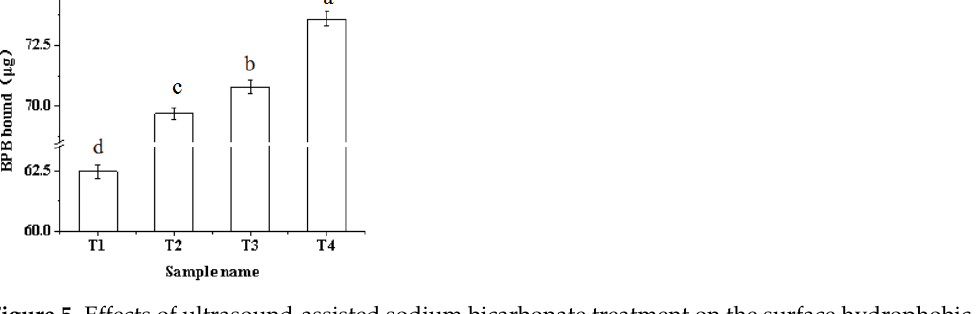
Figure 5. Effects of ultrasound-assisted sodium bicarbonate treatment on the surface hydrophobic of raw pork myofibrillar protein. T1, sodium bicarbonate 0 g, ultrasound time 0 min; T2, sodium bicarbonate 0.2 g, ultrasound time 0 min; T3, sodium bicarbonate 0.2 g, ultrasound time 30 min; T4, sodium bicarbonate 0.2 g, ultrasound time 60 min. Each value represents the mean ± SE, n = 4. a–d Different parameter superscripts indicate significant differences ( p < 0.05).